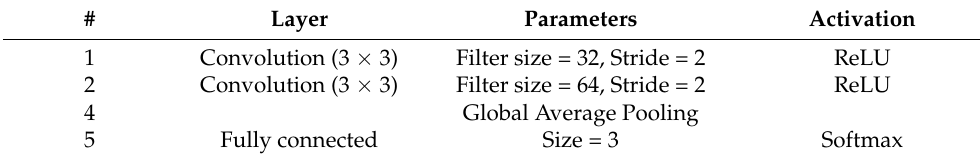
Table 4. The architecture of FSRNet.